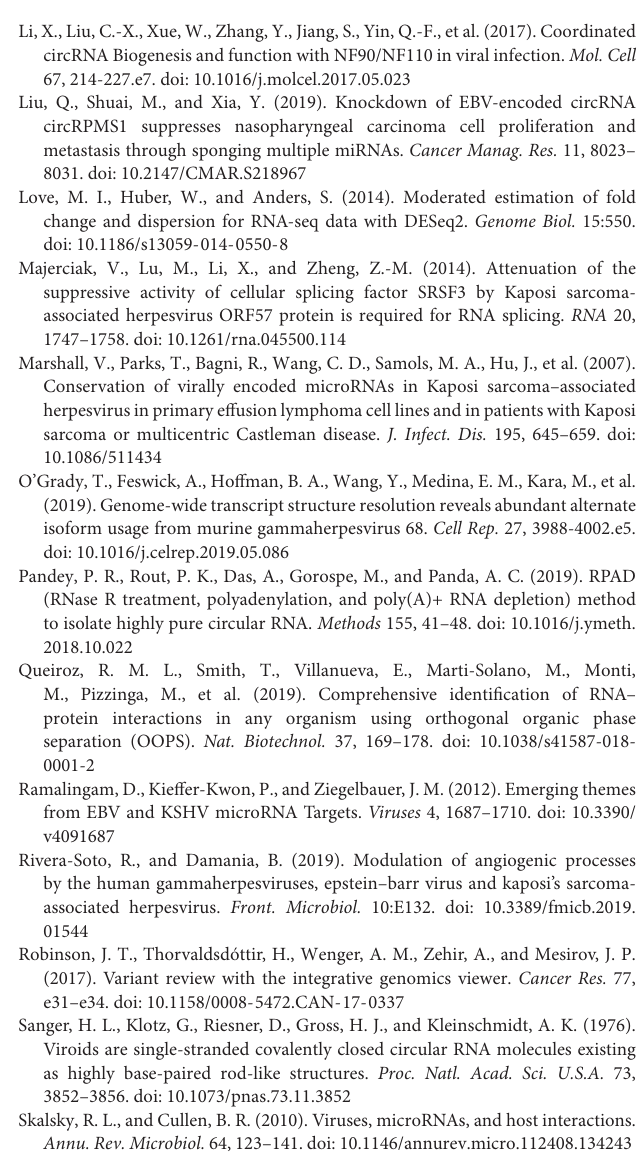
Supplementary Table 5 | SLK-circRNA DEG analysis. Differentially expressed gene analysis of SLK-circRNA cell lines by DESeq2. Supplementary Table 6 | circRNAs and RNA-binding proteins. Expression levels and contributions to circRNA production of genes that code for RNA-binding proteins [based on Queiroz et al. (2019) and Urdaneta et al. (2019)] are compiled based on publicly available data. Log2 Fold changes of gene expressions in KSHV-infected HUVECs (infected vs mock) are based on (Tagawa et al., 2018). Primary human umbilical vascular endothelial cells (HUVECs) were infected with KSHV. Effects on circRNA productions were determined by high-throughput screen and based on (Li et al., 2017). Supplementary Table 7 | Potential miRNAs sponged by viral circRNAs. TargetScan7.2 was utilized to predicted binding of human miRNAs to viral circRNAs as well as significantly upregulated gene upon ectopic expression of the viral circRNAs of interest ( Figure 6 and Supplementary Table 5 ). Binding affinity of 7 mer or better was used as valid predictions. miRNA families that can bind both viral circRNAs and DEGs are